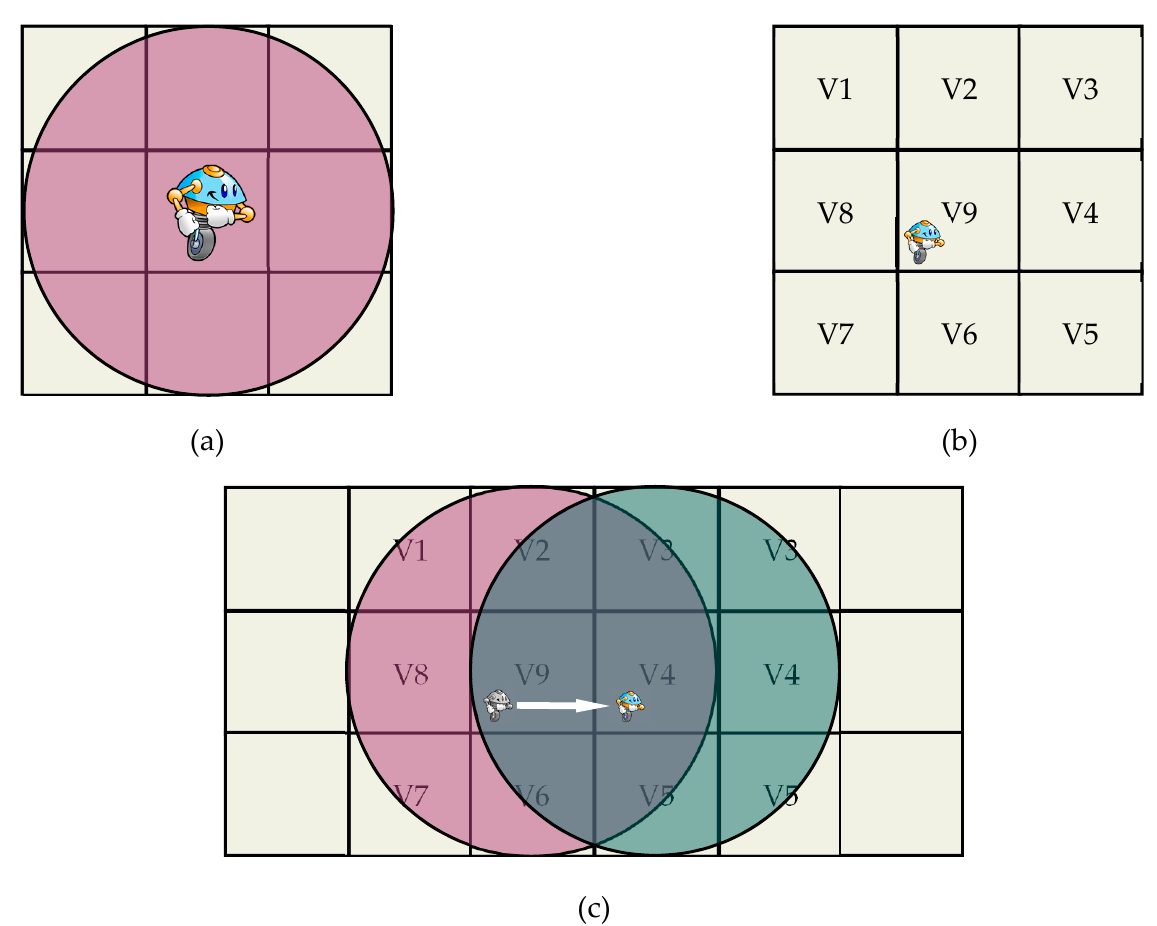
Figure 1. Senor view range in the grid cells: ( a ) sensor range cover [ V 1, . . . , V 8 ] around the robot; ( b ) eight cells around the robot and cell 9 is the robot position; ( c ) robot moving from right to left showing the sensor range does not cover the cost V 1, V 7, V 8 .